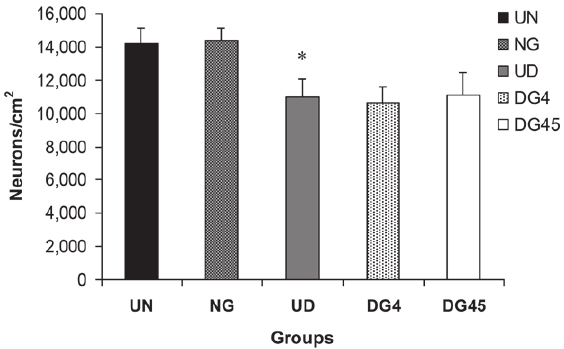
Figure 3 - Density (Neurons/cm 2 ) of myenteric neurons stained by myosin-V in the ileum of rats. Groups: untreated normoglycaemic (UN), glutamine-treated normoglycaemic (NG), untreated diabetic (UD), glutamine-treated diabetic (DG4), glutamine-treated diabetic (DG45). All results were shown as means ± standard error. n = 5 rats per group. *P < 0.05 when compared to group UN and